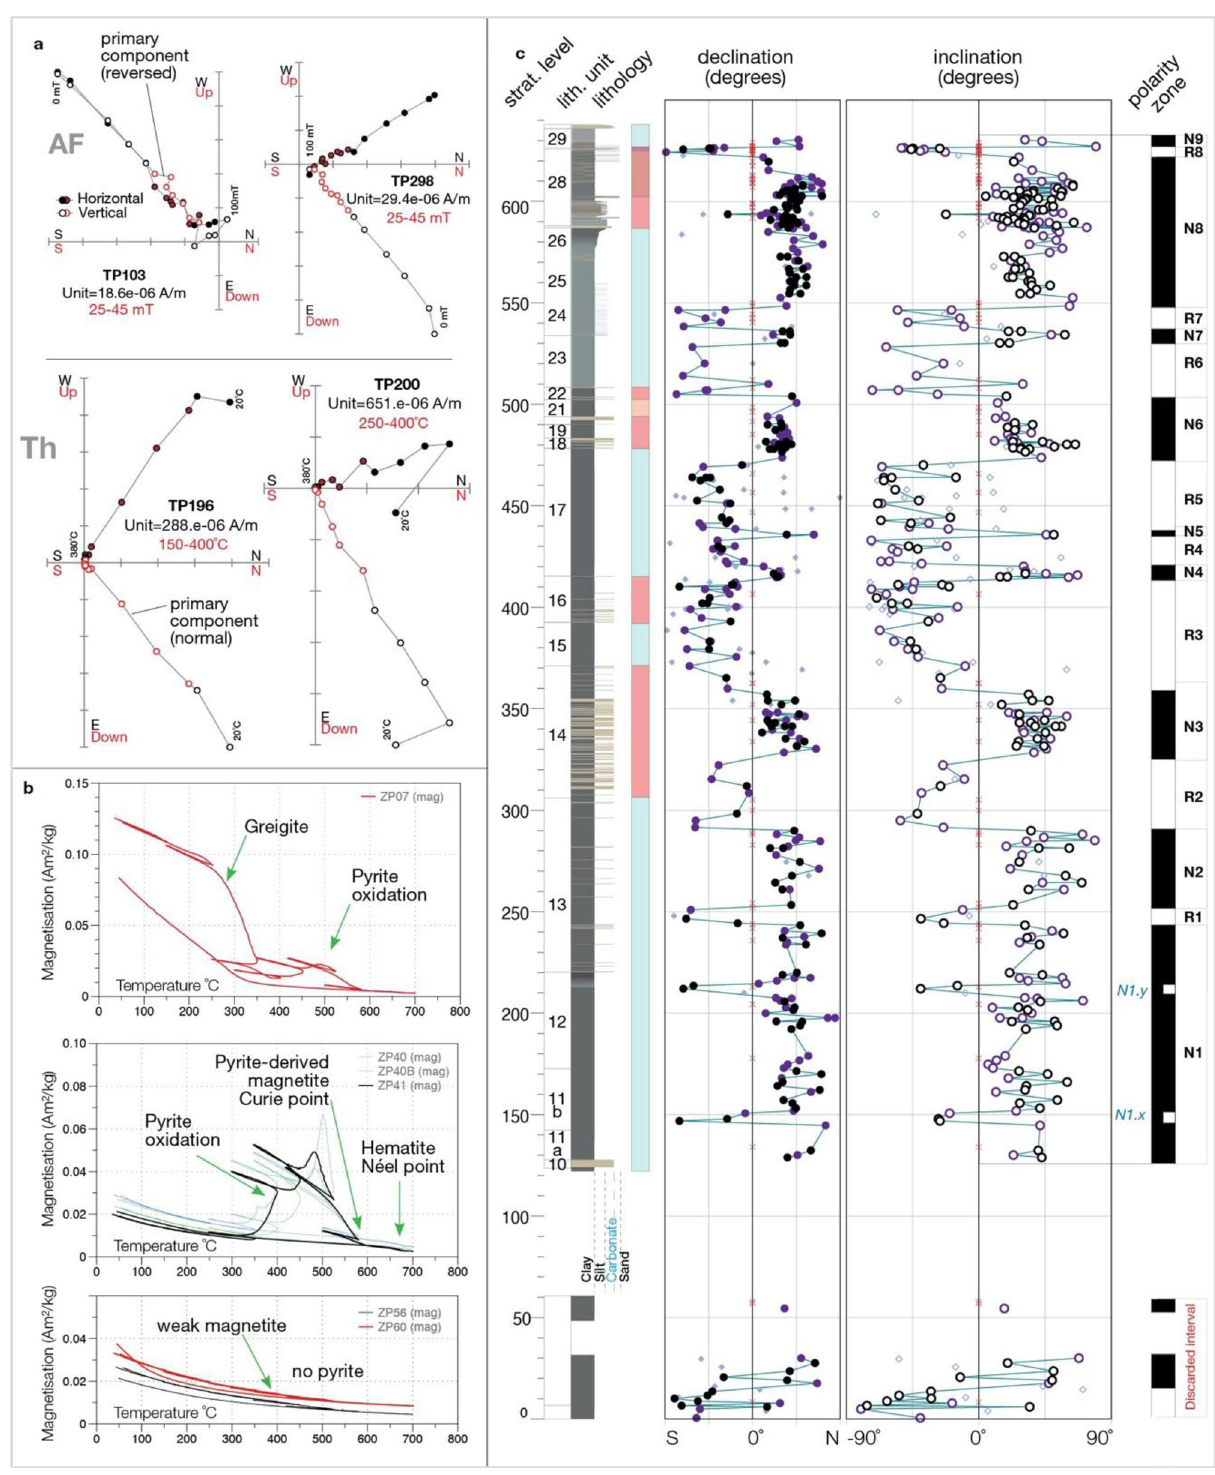
Figure 2. Paleomagnetic results from Cape Panagia. ( a ) Examples of demagnetization plots with normal and reversed polarities ( AF alternating field, Th thermal demagnetization) with intervals used for interpretation highlighted in red; ( b ) Thermal behaviour of samples from Cape Panagia, obtained from Curie balance experiments with multiple cooling and heating steps; ( c ) Magnetic directions plotted in stratigraphic order and local magnetic polarity pattern. Log and lithological unit numbers are edited, from Popov et al. 16 ; the coloured bar indicates Paratethys high-stands (light blue) and low-stands